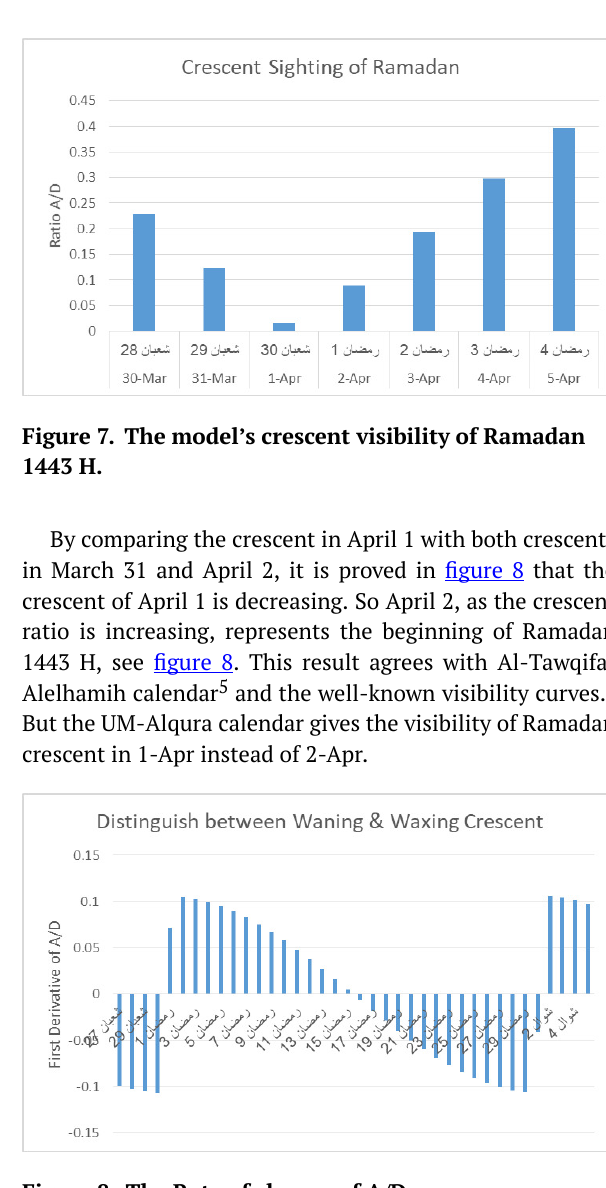
Figure 8. The Rate of change of A/D.